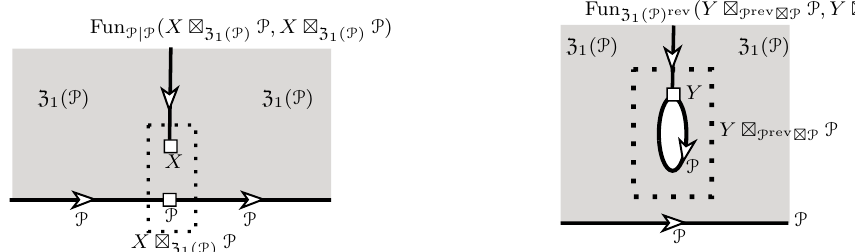
Figure 4 . Based on the boundary-bulk relation [51][53, Theorem 3.3.7], these pictures